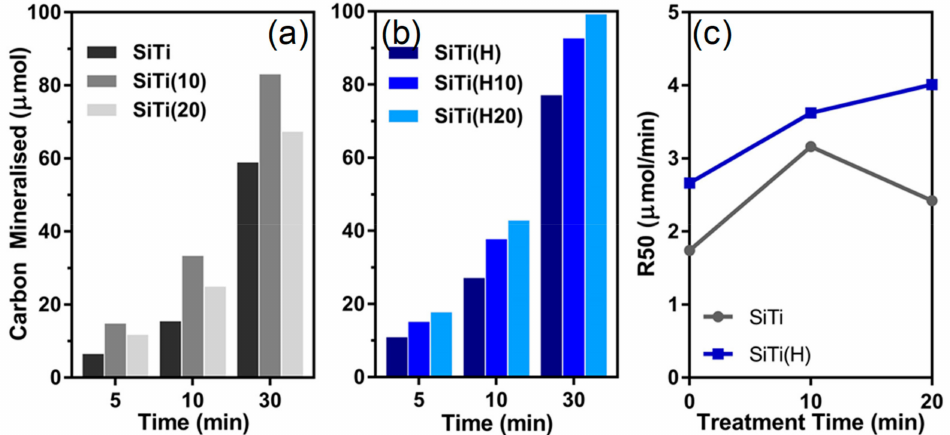
Figure 8. Carbon mineralization of ( a ) neat SiTi after plasma treatment, ( b ) hydrogenated SiTi after plasma treatment, and ( c ) the rate of photocatalytic formic acid oxidation (R 50 ). Catalyst loading = 1 g / mL; suspension volume = 50 mL; suspension pH = 3 ± 0.1; formic acid loading = 100 µ